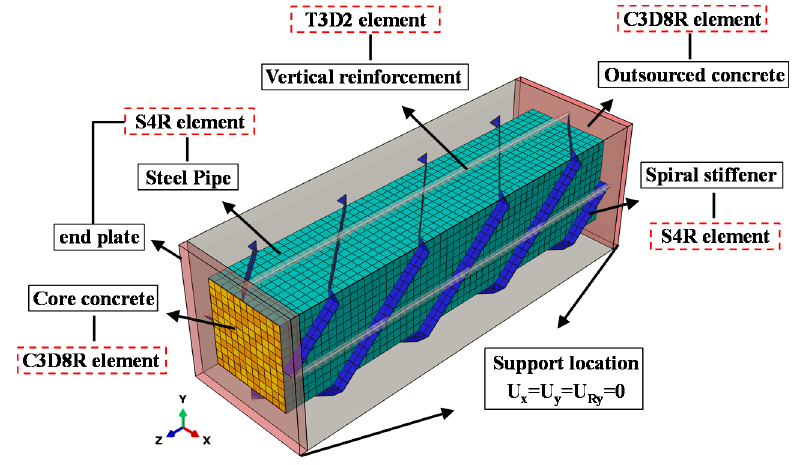
Figure 16. The finite element model of specimen Z3.